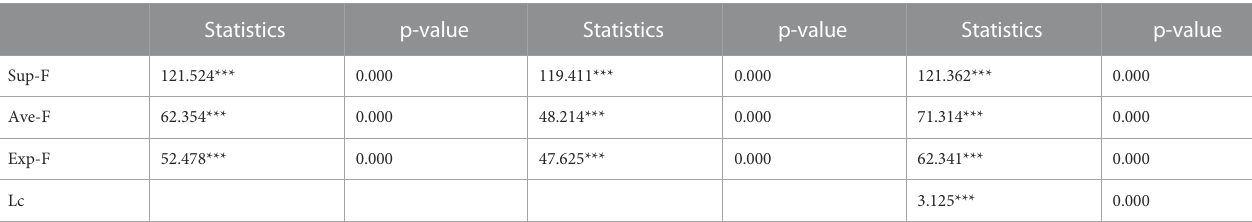
TABLE 10 Parameter stability test.